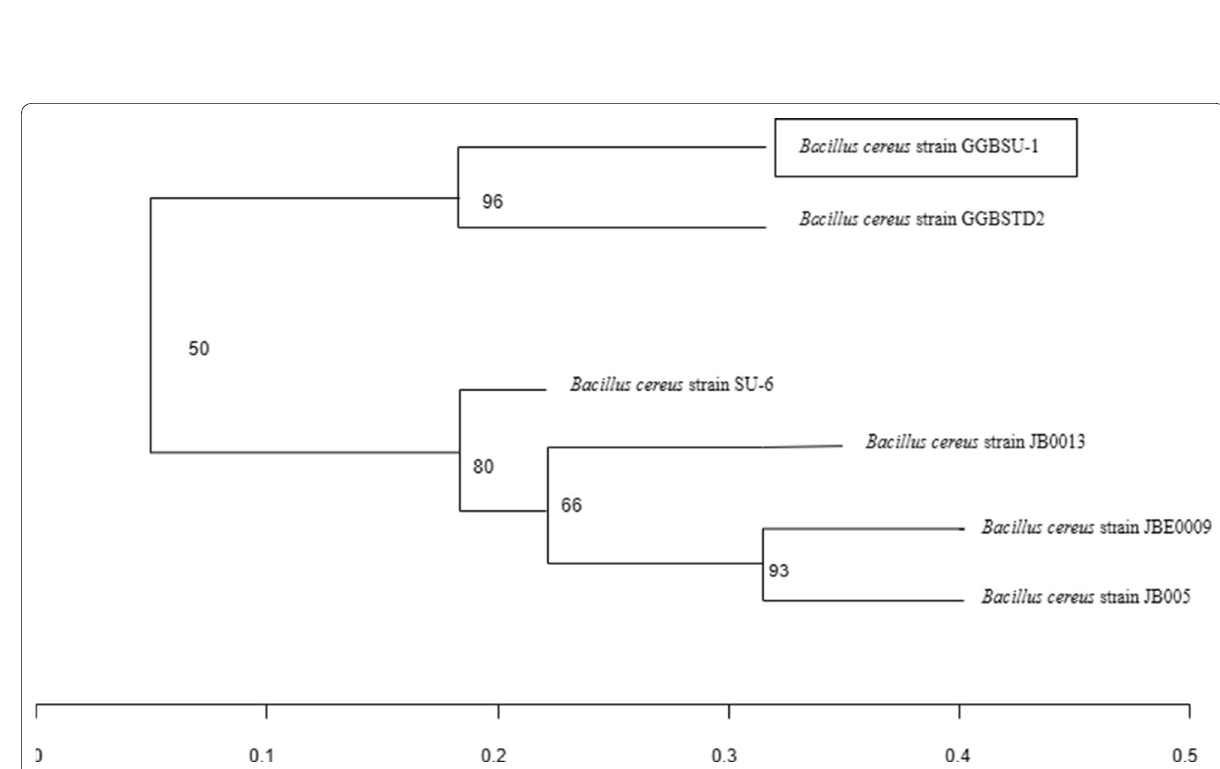
Fig. 15 Phylogenetic tree showing the relationships between the phosphate-solubilizing bacteria (PSB) isolates in this study and their closest phylogenetic relatives based on 16S rRNA gene sequencing. Isolate with rectangle was identified in this